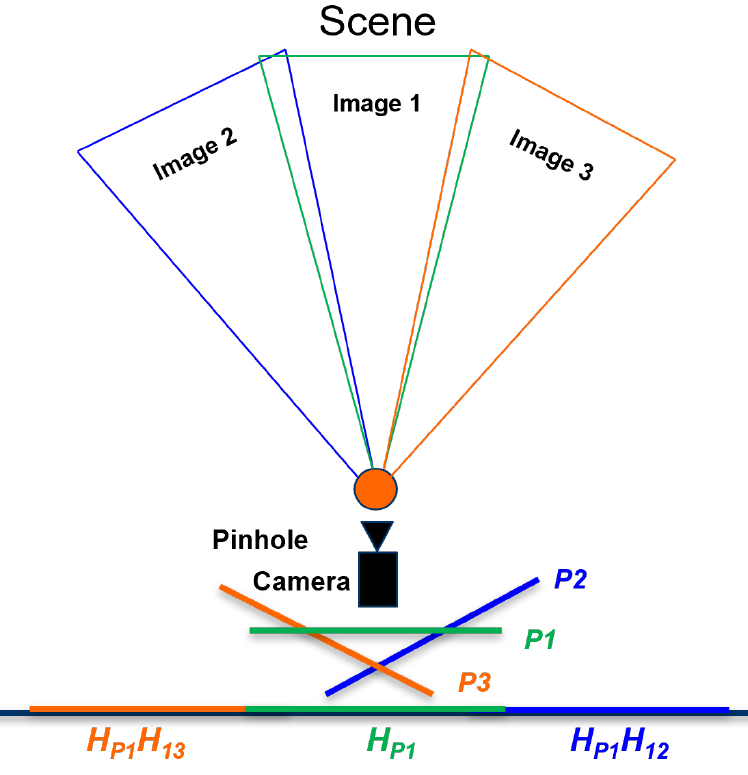
Figure 2. A diagram showing how images that are located on different planes can be related via homography to a common plane, assuming that all the images have a common projection point (a pinhole camera